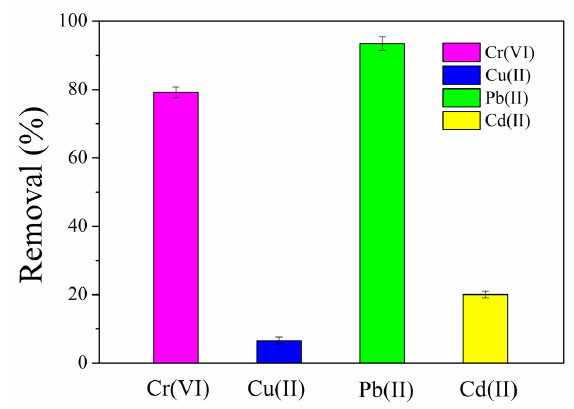
Figure 6: Removal of heavy metals from industrial wastewater by the GO-NH . [conditions: initial concentrations of Cr(VI), Cu(II), Pb(II) 2 and Cd(II) were 15.47, 11.01, 7.59 and 3.88 mg L −1 ,